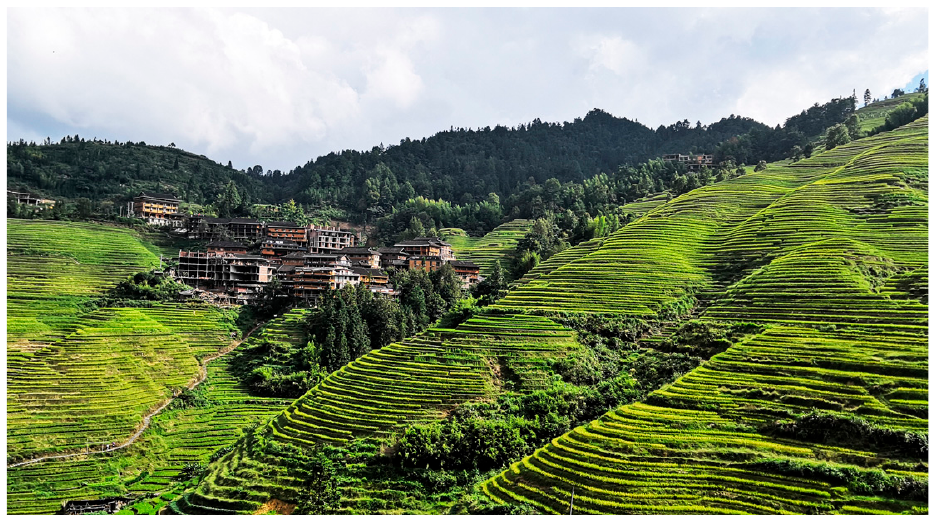
Figure 10. Landscape of Longji terraces.